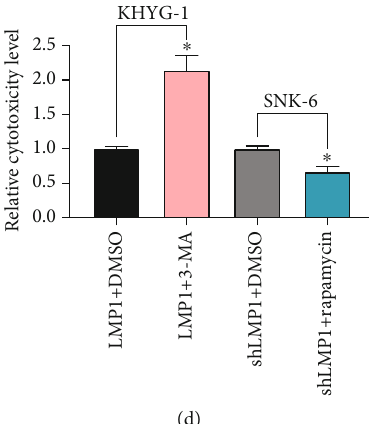
Figure 3: Inhibition of cell autophagy reduces the promoting e ff ect of LMP1 on the lymphoma cell resistance to DDP. The autophagy inhibitor 3-MA was added to the KHYG-1 cells overexpressing LMP1, and the autophagy activator rapamycin was added to the SNK-6 cells poorly expressing LMP1. (a) The autophagy level was observed by MDC staining. (b) The IC50 value of KHYG-1 and SNK-6 cells to DDP measured by the CCK-8 kit. (c) Cell proliferation was detected by colony formation assay. (d) The cytotoxicity of DDP to the KHYG-1 and SNK-6 cells tested by LDH kit. All data are displayed in the form of mean ± standard deviation . (a, c, and d) One-way ANOVA and Tukey ’ s multiple comparison test are used to test the signi fi cant di ff erence of data. (b) Two-way ANOVA and Tukey ’ s multiple comparison test are used to test the signi fi cant di ff erence of data. ∗ p < 0 : 05 .